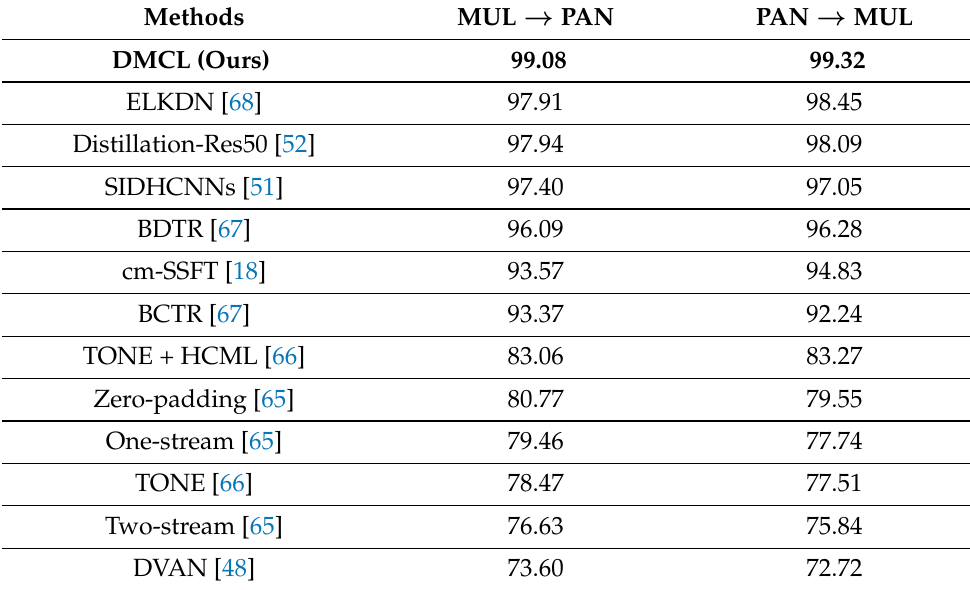
Table 2. MAP values (%) of different models for the DSRSID. MUL → PAN means the query is MSP images, and the target samples are PAN images. PAN → MUL indicates the query is PAN images, and the target samples are MSP